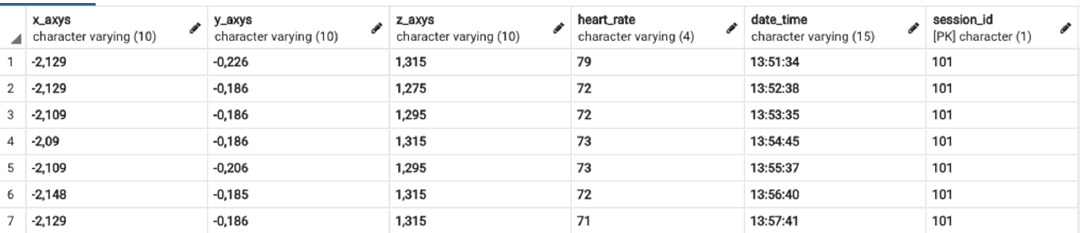
Figure 25. Example of data in the “Session” table.